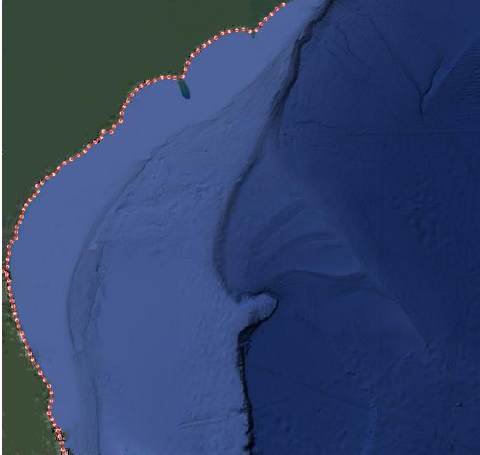
Figure 11. Marks on the coastline in the maritime area near the east coast of North America.